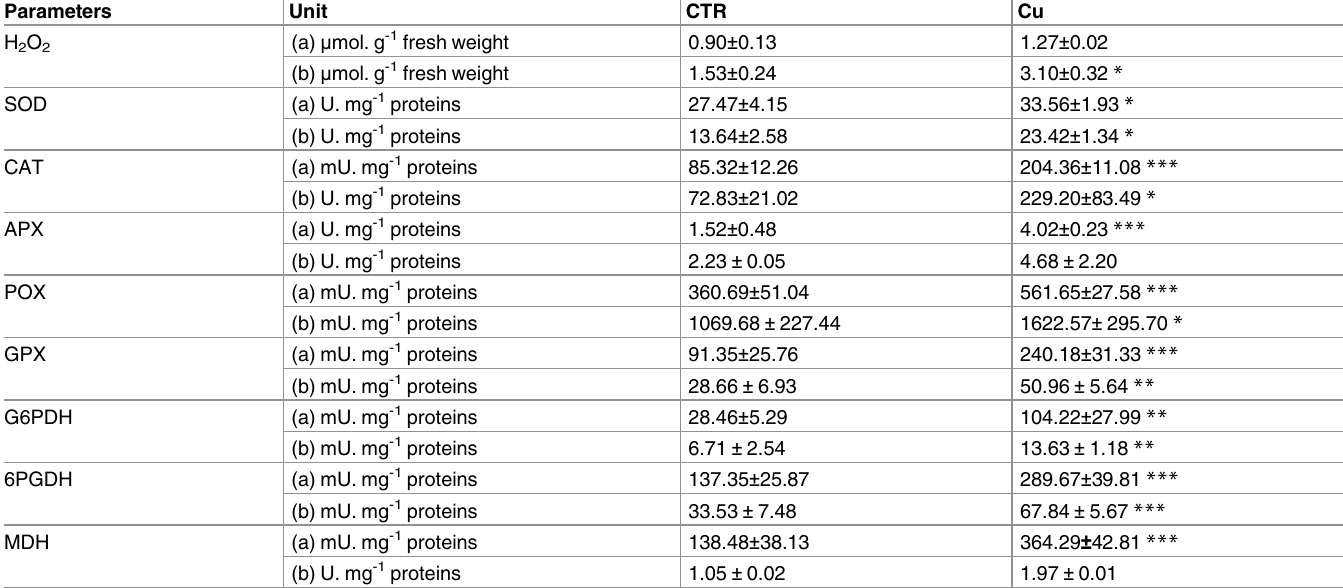
Table 1. Level of H 2 O 2 and activities of antioxidant enzymesin the seedlings after 3 days (a) and cotyledons after 9 days (b) of germinated bean seeds in the presenceof H 2 O (CTR) or 200 μ M Cu.